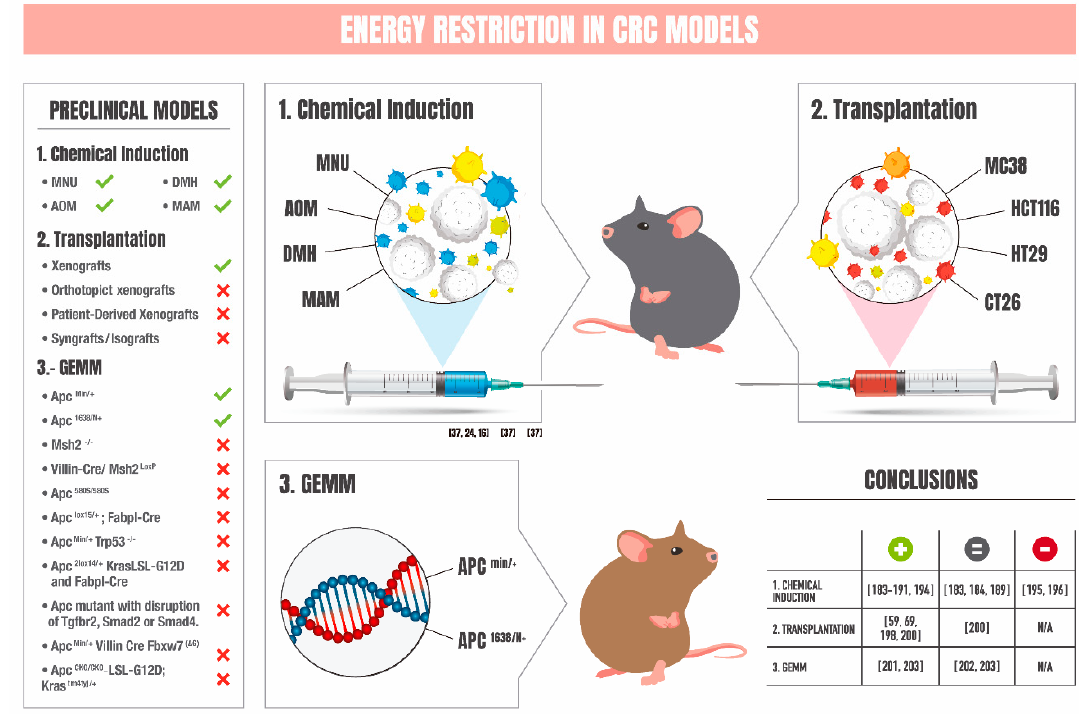
Figure 3. Energy restriction strategies implemented in preclinical models of colorectal cancer. The main preclinical models used for the study of colorectal cancer are shown in the left column and described elsewhere [189]. Within this column, green ticks indicate those models in which interventions based on energy restriction have been applied. These models are illustrated in the central panel of the figure, with the main conclusions (positive, negative, or unchanged) of the studies summarized in the adjacent table (bottom right). Note that for several studies, the positive or unchanged response against carcinogenesis depends on multiple factors that influence energy restriction, such as diet, dose of restriction, or onset of the intervention. GEMM = Genetically Engineered Mouse Models; MNU = N-methylnitrosurea; MAM = methylazoxymethanol acetate; AOM = azoxymethane; DMH = dimethylhydrazine; APC = Adenomatous Polyposis Coli.